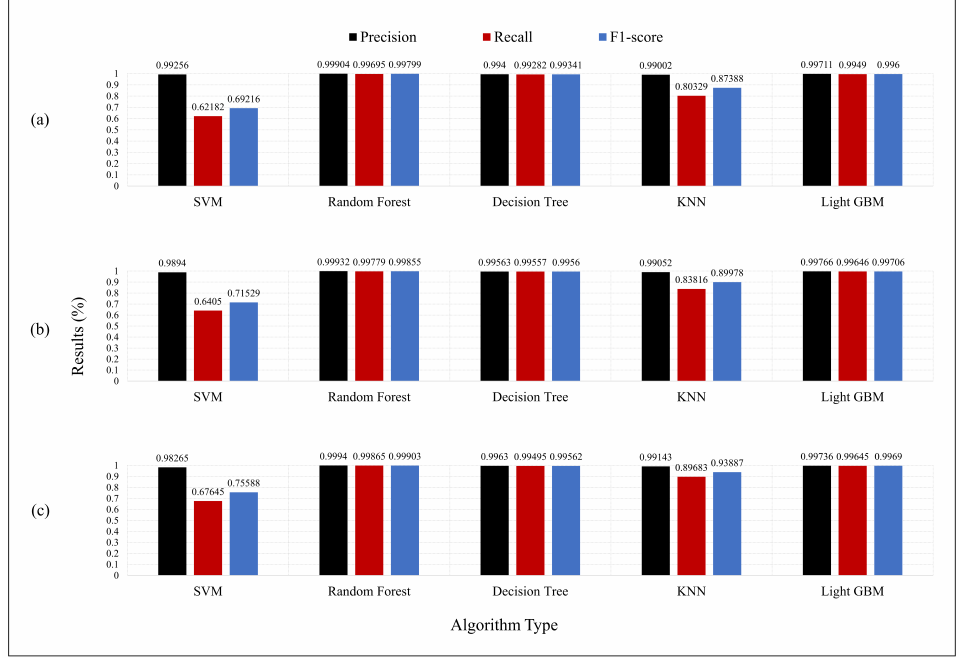
Figure 3. Result of model training. The time window size is ( a ) 30 s, ( b ) 60 s, and ( c ) 90